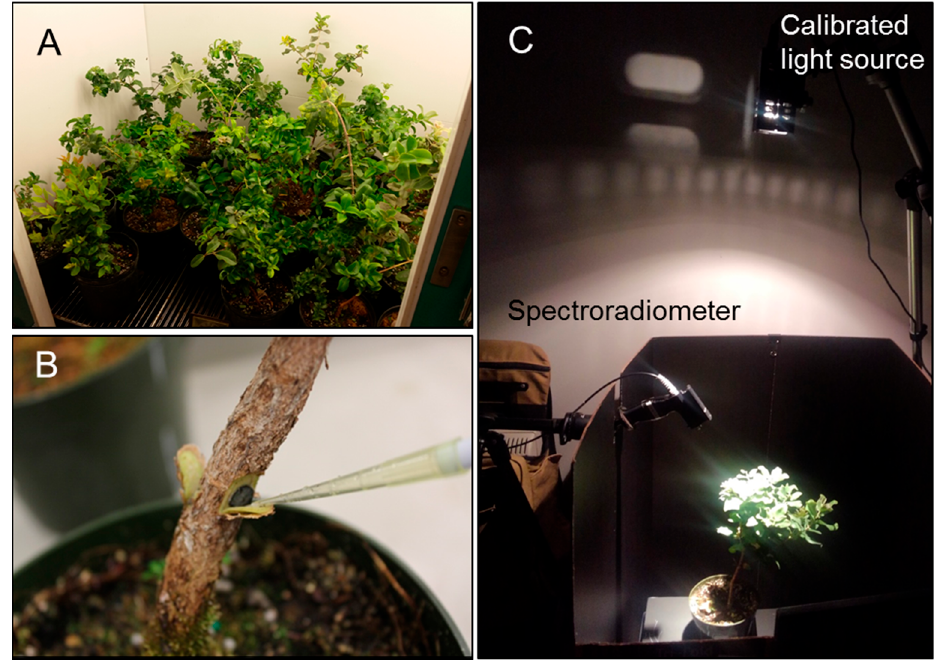
Figure 2. Laboratory experimental set-up. ( A ) ‘ ō hi‘a seedlings in the growth chamber, ( B ) inoculation procedure for an ‘ ō hi‘a seedling, ( C ) spectral data collection measurement chamber.